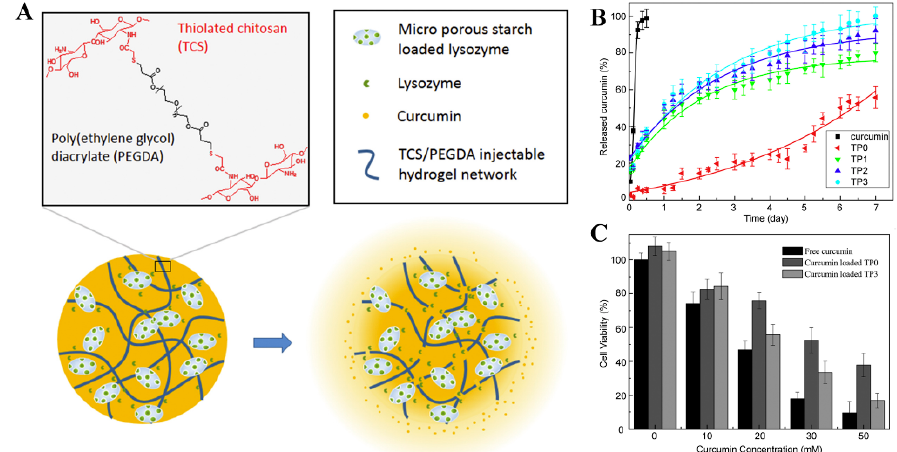
Figure 8. ( A ) Scheme of thiolated chitosan/poly(ethylene glycol) diacrylate (TCS/PEGDA) injectable hydrogel for localized intratumoral delivery of anti-cancer drugs. ( B ) Curcumin release behavior from TCS/PEGDA injectable hydrogel in PBS buffer at 37 °C with shaking (100 rpm). TP0 is the gel with micro porous starch but without lysozyme; TP1, TP2 and TP3 are the gels with micro porous starch adsorbed 0.46, 0.60 and 0.75 g/g lysozyme, respectively. ( C ) HepG2 cells viability determined using MTT assay when incubated with free curcumin, and curcumin loaded TCS/PEGDA injectable hydrogels with (TP3) or without (TP0) lysozyme, respectively. Adapted from reference [252]. Copyright 2017 Elsevier B.V.